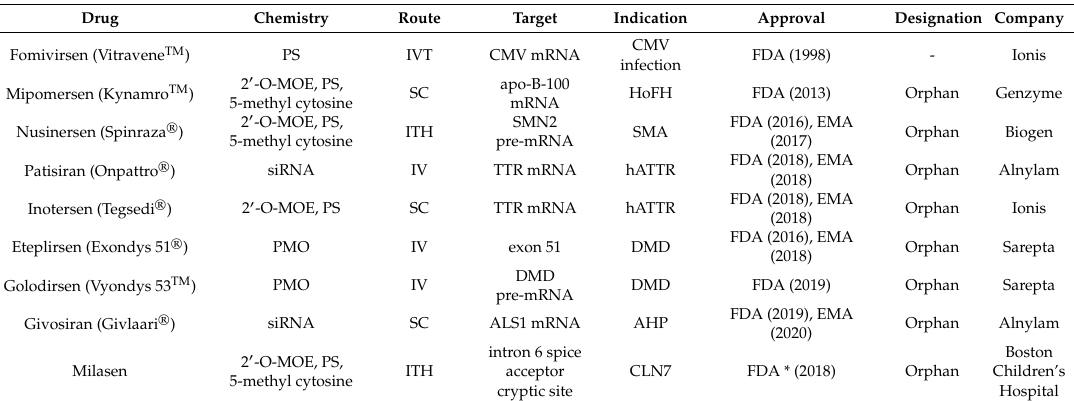
Table 2. FDA approved